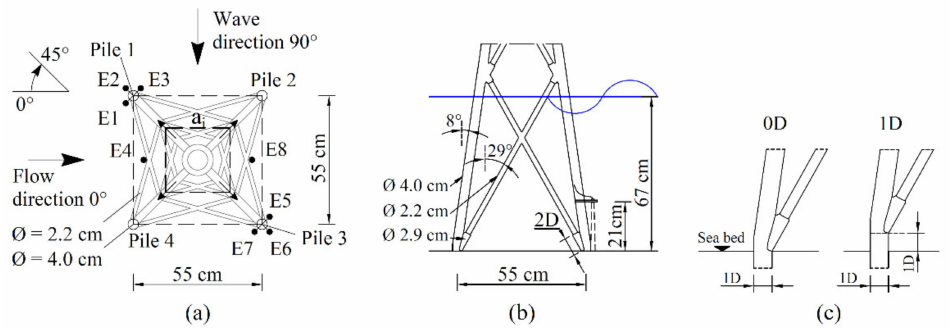
Figure 2. Schematic view on the jacket model: ( a ) plan view, including the increasing interrogation areas a i ; ( b ) side view, with dimensions, angles and water level, D = 4 cm; and ( c ) side view on the lowest node positioned directly on seabed 0D, in comparison with a distance of